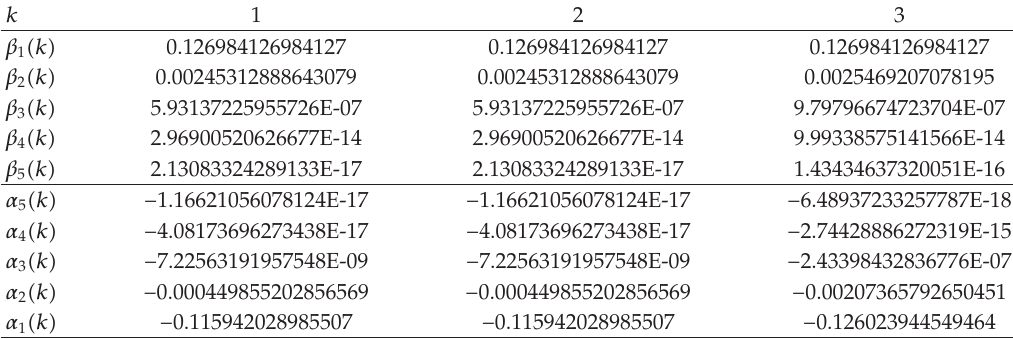
Table 1: Values of successive approximations α n (cid:3) k (cid:6) and β n (cid:3) k (cid:6) , n (cid:8) 1 , 2 , 3 , 4 , 5. k 1 2